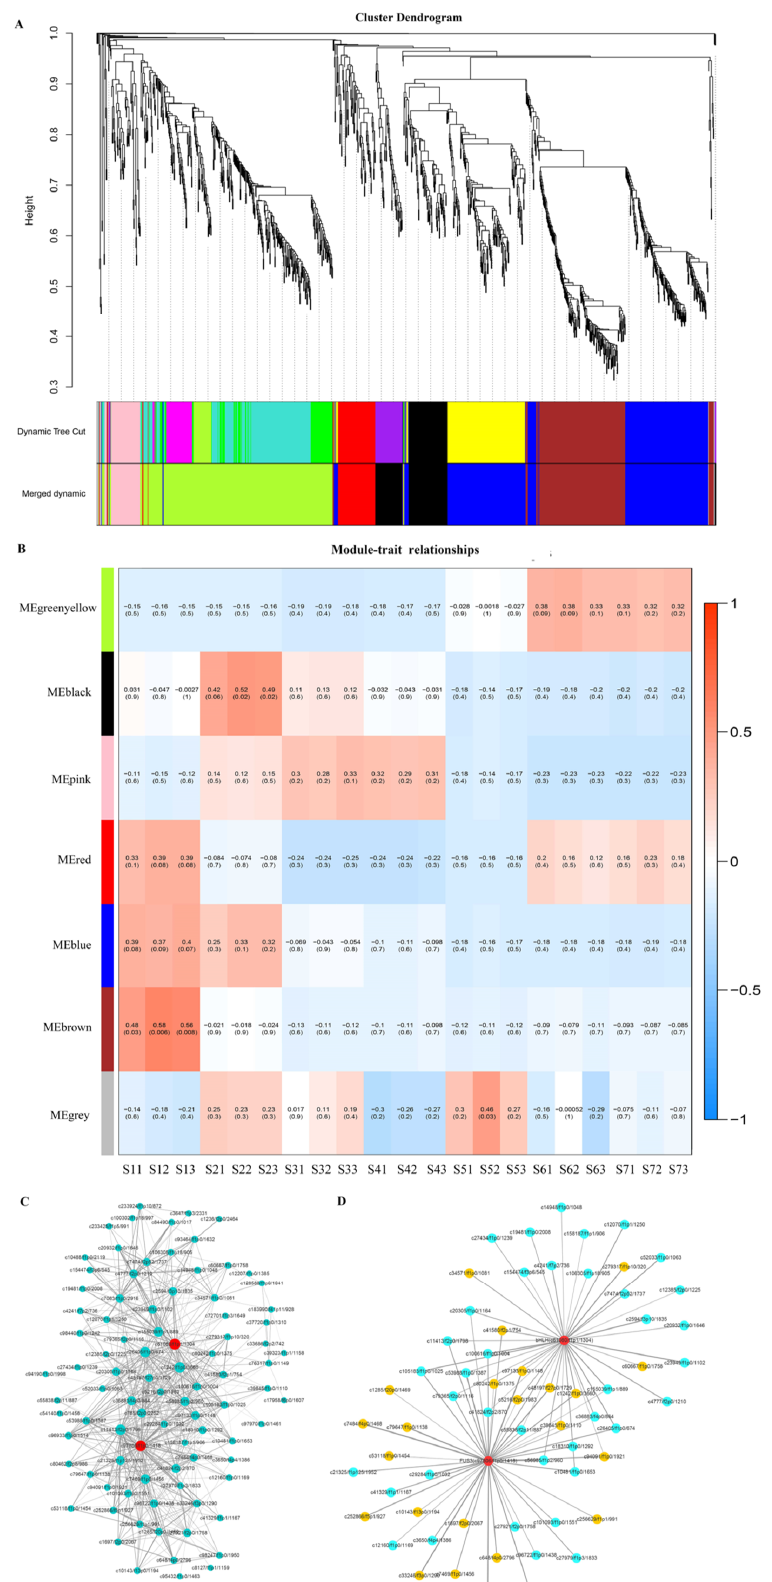
Figure 7. Weighted gene co-expression network analysis (WGCNA) of genes during the seed devel- opment process. ( A ) Gene co-expression modules detected by WGCNA. The clustering dendrogram of the genes across all the samples exhibits dissimilarity based on topological overlap, together